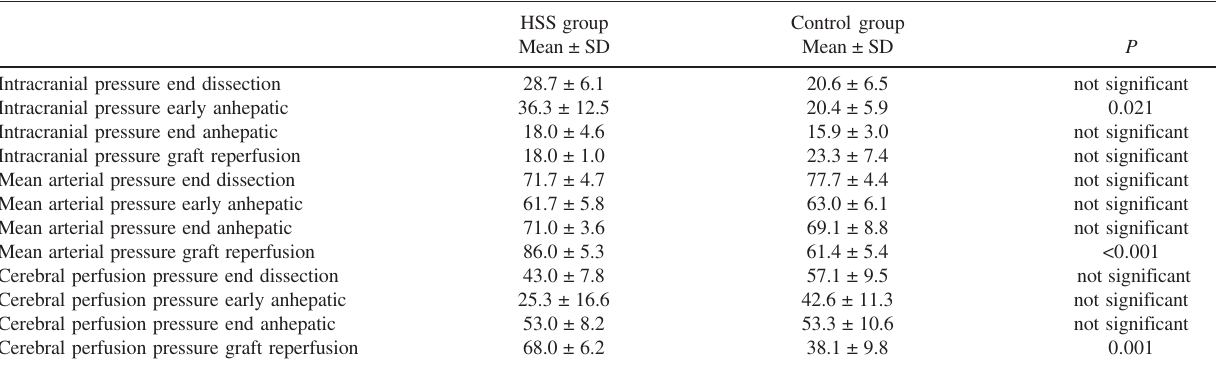
Table 1 - Mean Systemic and Cerebral Hemodynamic Values (mm Hg)